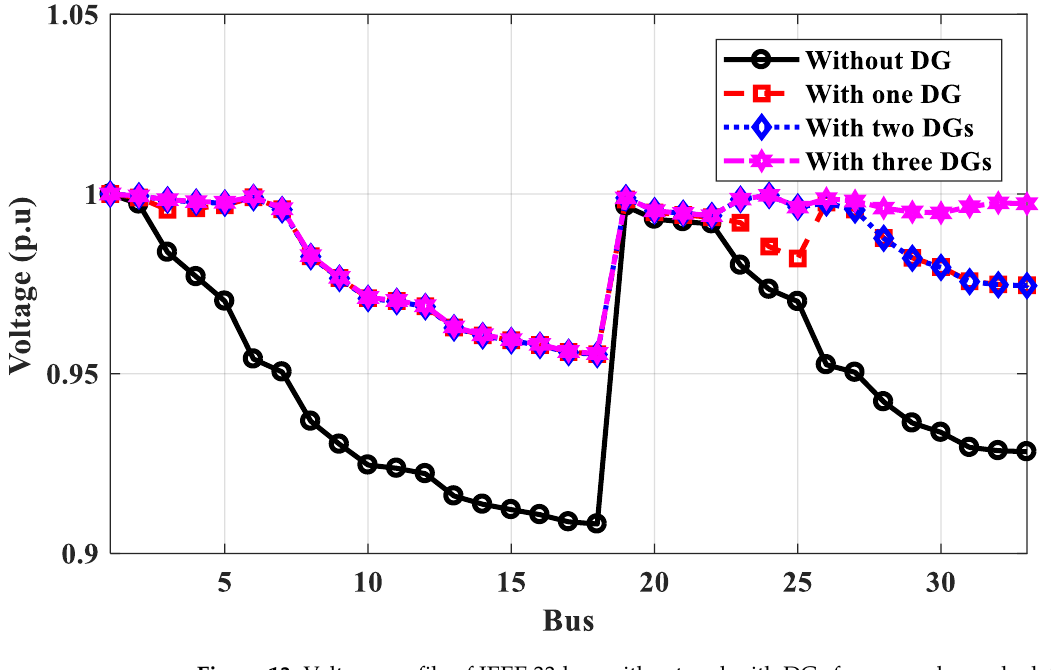
Figure 13. Voltage profile of IEEE 33-bus without and with DGs for power loss calculation.